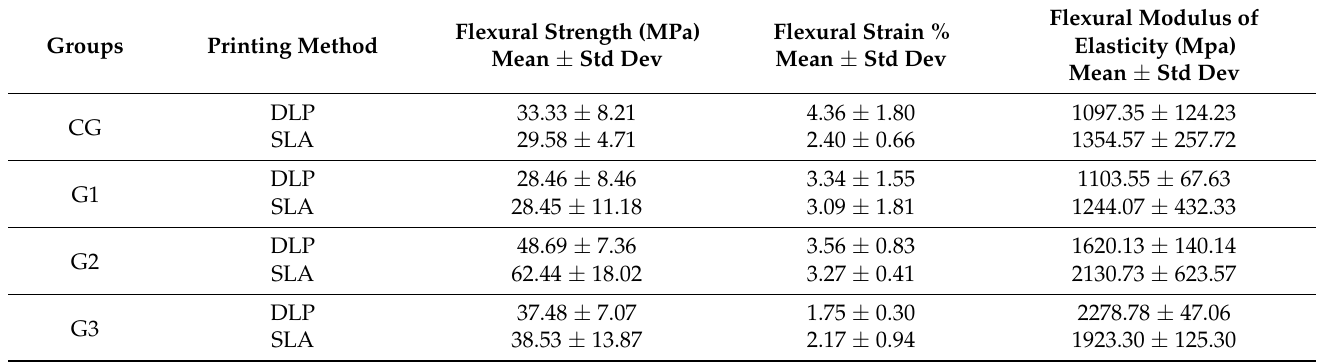
Table 1. Mean and standard deviations of the measured parameters of the specimens obtained during the flexural